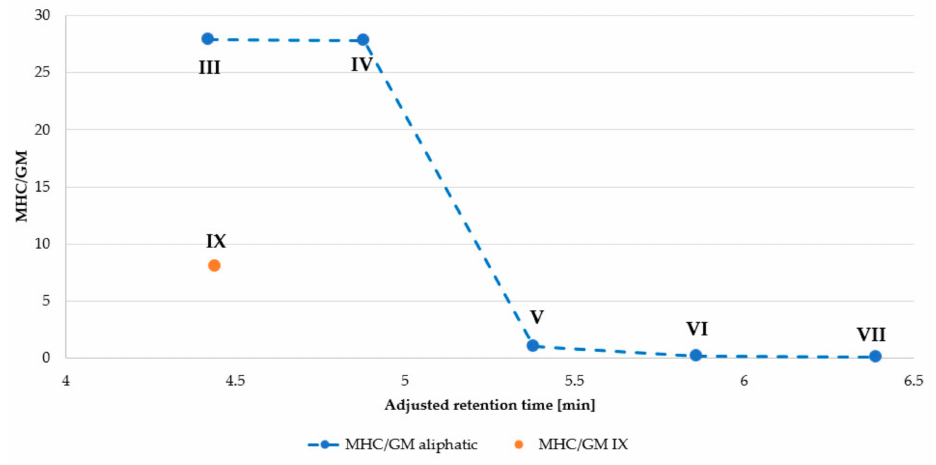
Figure 4. Selectivity for S. aureus over erythrocytes versus adjusted retention time.